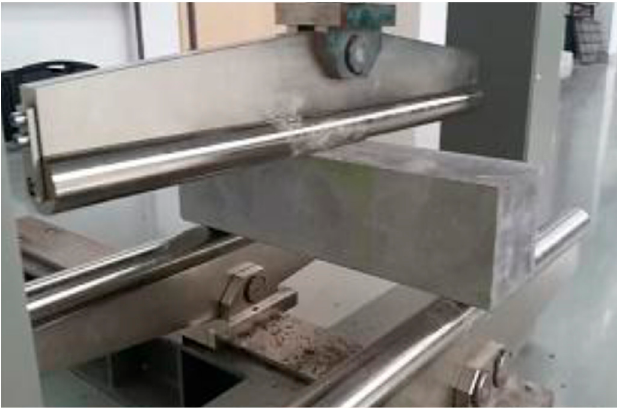
Figure 4. Flexural strength test of C-REF.